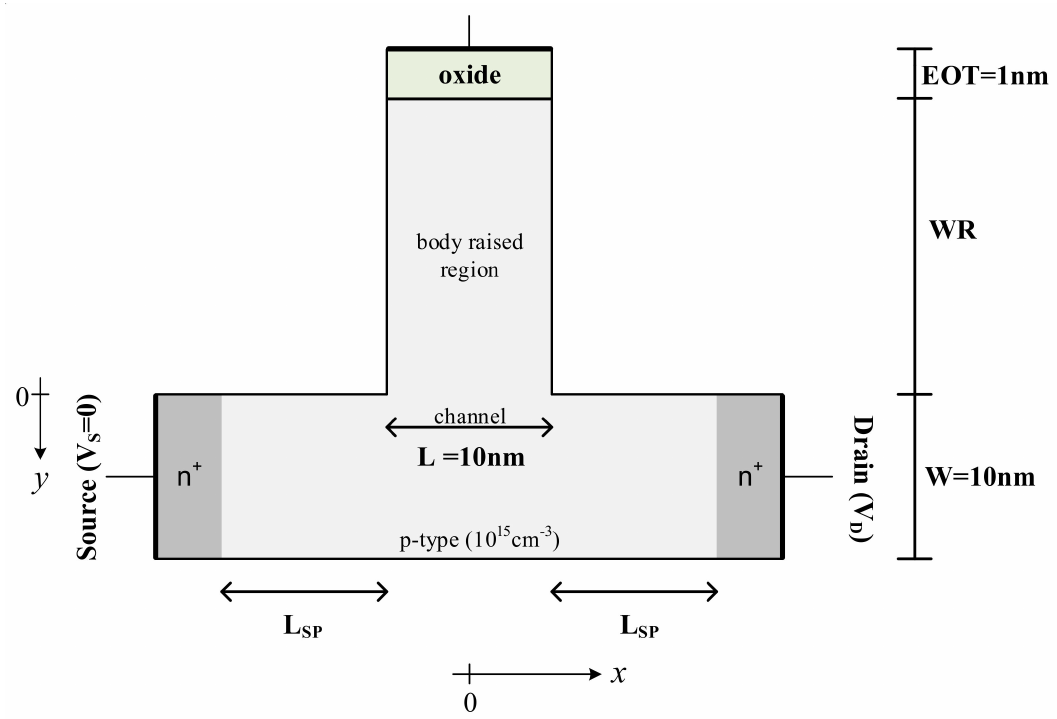
Figure 1. The simulated device structure: source/drain are separated from the low doped channel region (length L, thickness W) by a spacer region (length L SP ). A raised body region (height WR) is used to accommodate excess charge during HOLD